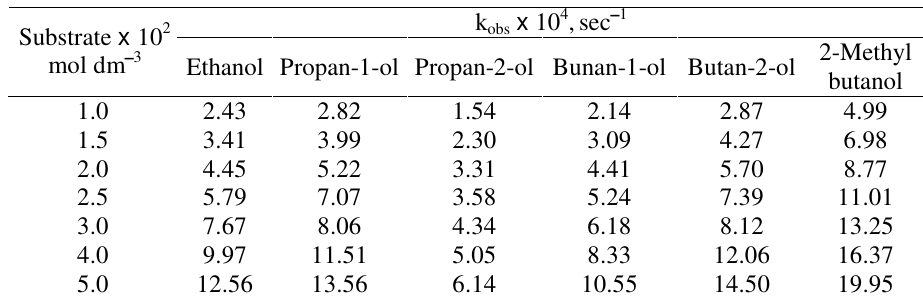
Figure 1. Variation of rate with substrate concentration. Table 1. Variation of rate with substrate